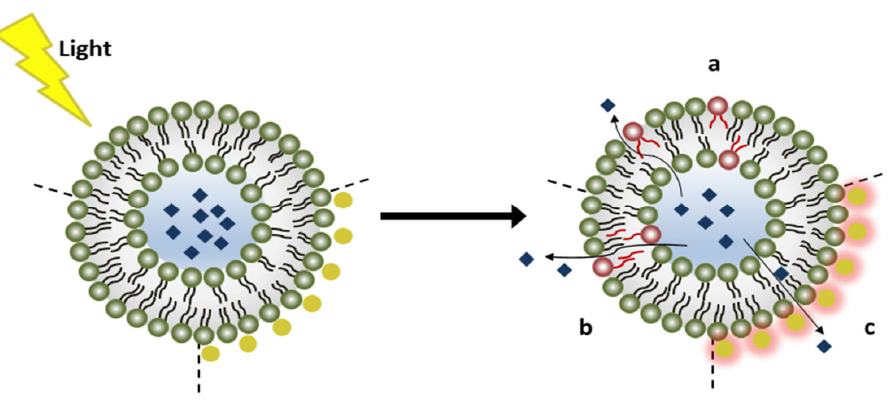
Figure 1. Photo ‐ induced mechanisms used in triggering drug release from nanocarriers. (a) Photo ‐ isomerization; (b) Photo ‐ cleavage; (c) SPR of Gold NPs for thermo ‐ sensitive nanocarriers, gold NPs can be on the surface or inside. can be on the surface or